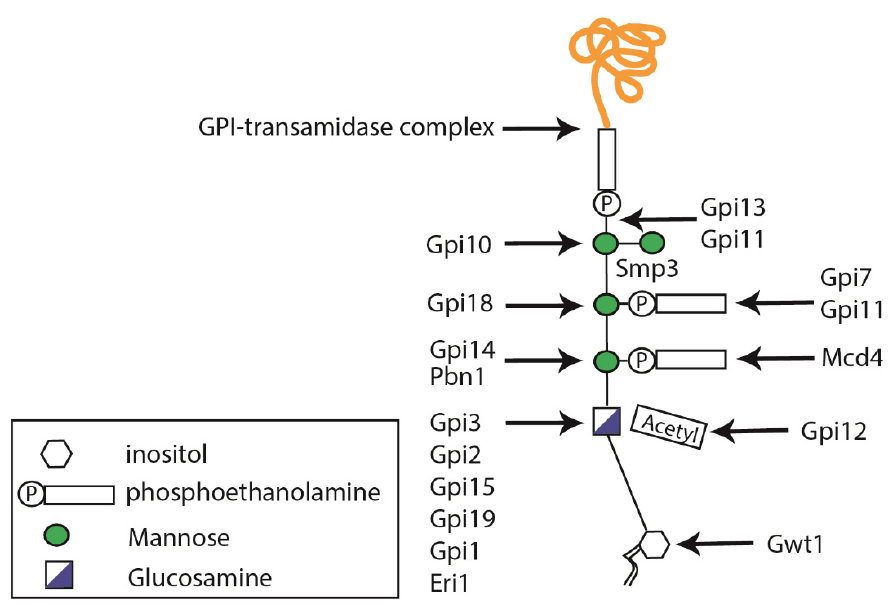
Figure 2. Schematic diagram representing glycosylphosphatidylinositol (GPI) anchor synthesis. GPIs are composed of an inositol molecule that is modified in the endoplasmic reticulum. The Smp3 protein is responsible for adding the fourth mannose residue, which is important for protein transfer.